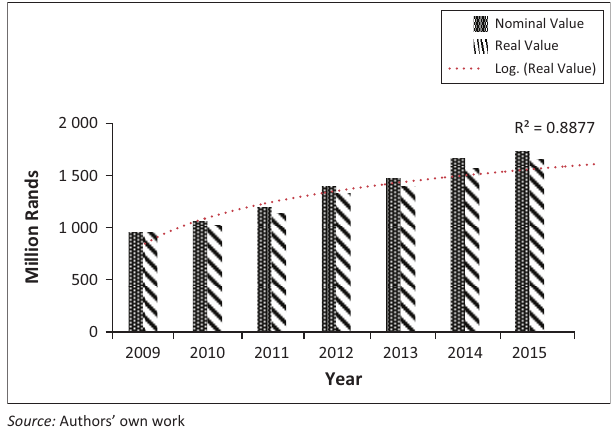
FIGURE 5: Total expenditure: Potchefstroom Campus, 2009–2015. TABLE 1: Activity with corresponding sector. Activity